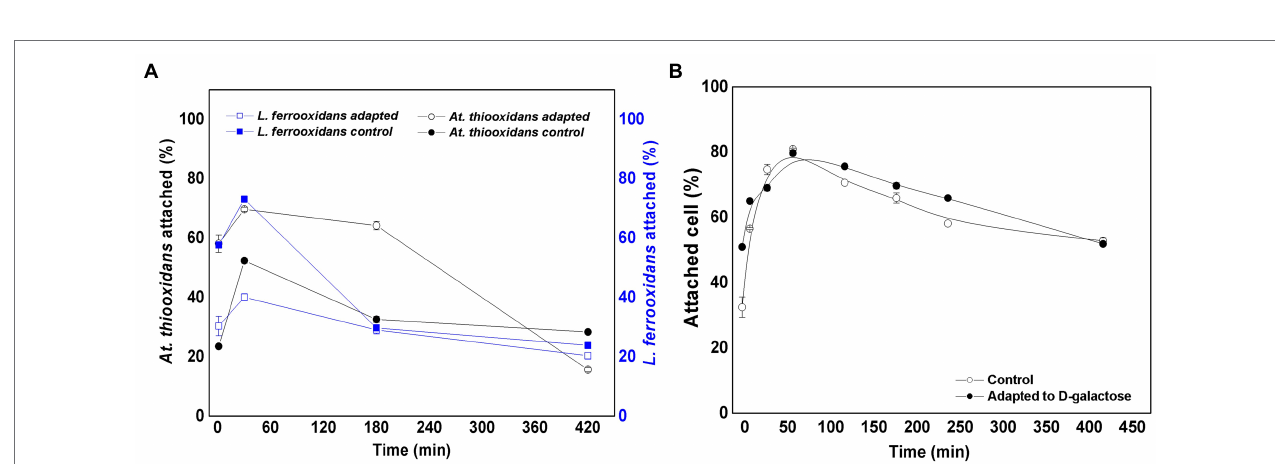
FIGURE 3 | Attachment percentage to the mineral over time for the consortium in proportion 70:30 of At. thiooxidans DSM 14887 T and L. ferrooxidans DSM 2705 T , respectively. (A) Data obtained by qPCR. (B) Data obtained by counting of total planktonic cells using a Neubauer chamber. The data correspond to the mean values of triplicates ± SD ( n =